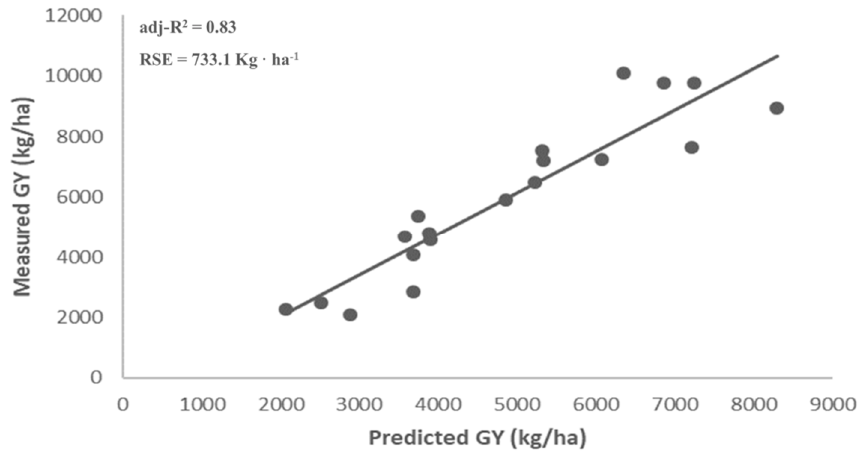
Figure 4. Stepwise equation validation, correlation of predicted against actual 2019 grain yield (GY). The adjusted R 2 correlation of the estimated GY (kg · ha − 1 ) with the stepwise equation developed for the previous season against reported grain yields in 2019.